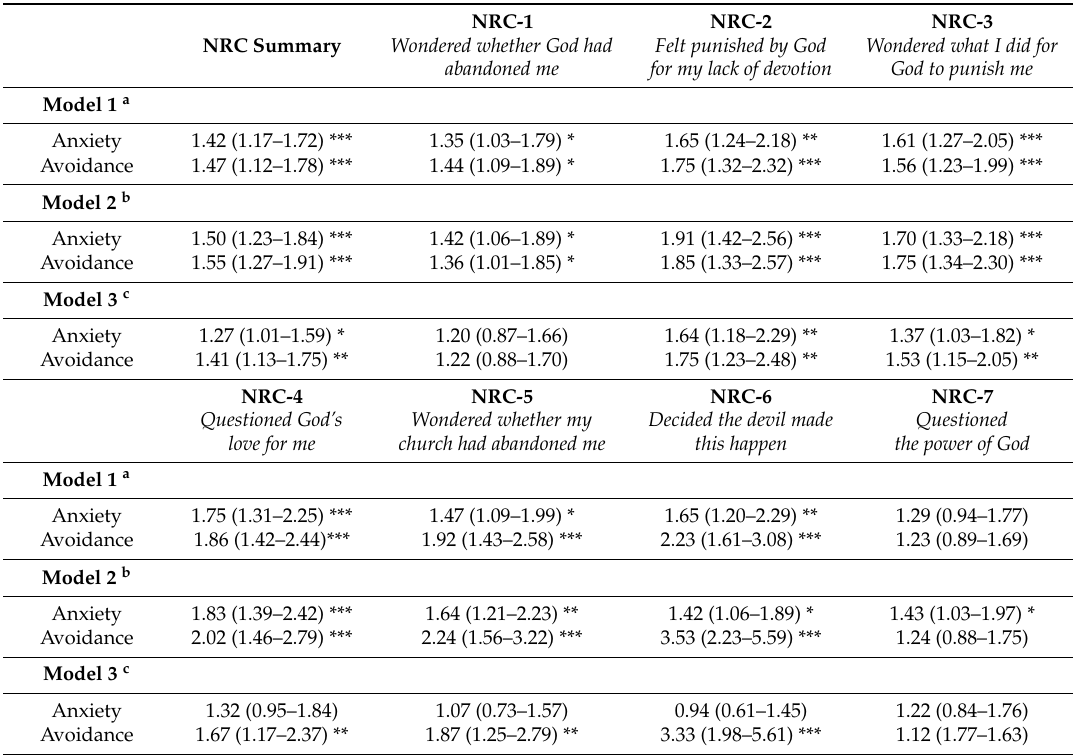
Table 2. Associations of experience in a close relationship (avoidance and anxiety) with negative religious coping and its items standardized to z-scores, crude, adjusted for age, gender, marital status, and education plus adjusted for raw anxiety and depression: results of binary logistic regression models leading to odds ratios with 95% confidence intervals.